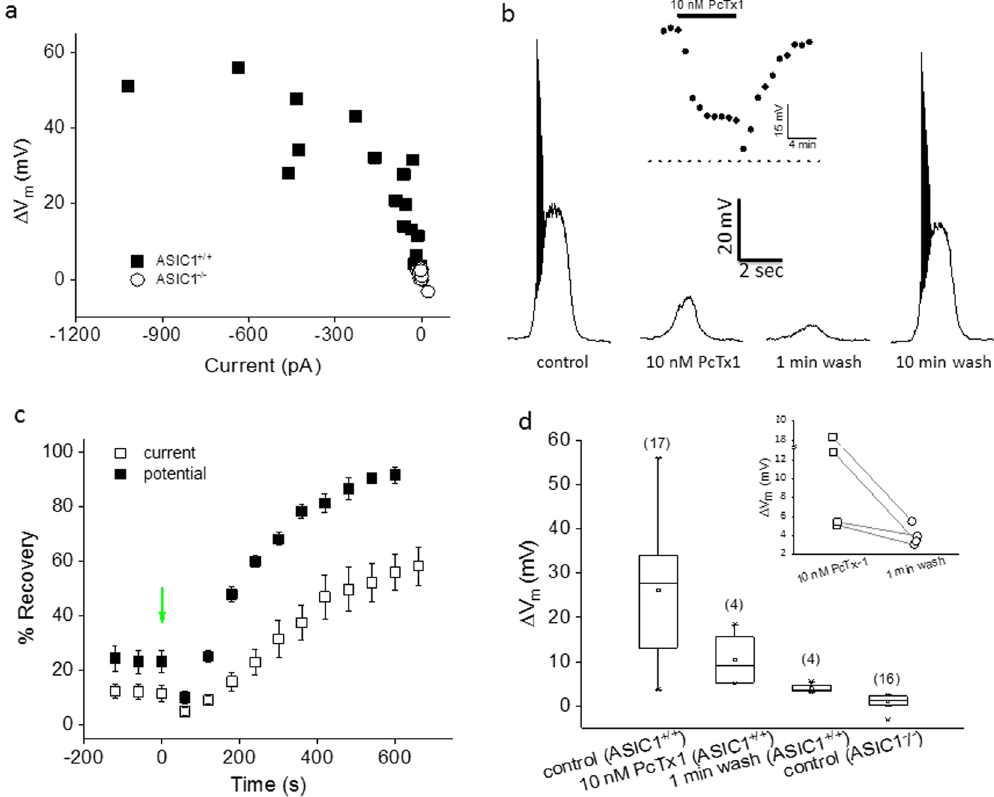
Figure 5. Potentiation of ASIC1a/2a by low concentration PcTx1 in mouse cortical neurons. ( a ) Correlation between pH6.8-induced current and membrane depolarization in wild-type (solid squares; n = 17) and ASIC1 − / − (open circles; n = 16) neurons. Each symbol represents one neuron. ( b ) Traces of pH6.8-induced membrane depolarization from a single neuron in the absence and presence of 10 nM PcTx1. Inset: Time course of the effect of 10 nM PcTx1 and wash. The dotted line at the bottom represents the baseline. ( c ) Time courses of pH6.8-induced responses upon removal of 10 nM PcTx1. Wash began at t = 0 sec as indicated by the green arrow. Open squares: current (n = 4); solid squares: membrane potential (n = 4). Responses were normalized to the control values for each cell just before application of 10 nM PcTx1. Note the initial lower responses (at t = 60 sec) than those in the presence of 10 nM PcTx1 (at t ≤ 0 sec). ( d ) Summary of pH6.8-induced membrane depolarization in wild-type and ASIC1 − / − neurons. Values for wild-type neurons during and upon initial wash of 10 nM PcTx1 were both significantly higher than that from ASIC1 − / − neurons (p < 0.05 and p < 0.0001, respectively). Inset: pair-wise comparison of pH6.8-induced membrane depolarization in the presence of 10 nM PcTx1 and 1 min after wash-off. The former was larger than the latter for all the four wild-type neurons tested, despite not reaching statistical significance (p = 0.11). A typical protocol used for experiments in Fig. 5 was as follows. For current recording, the holding potential was − 80 mV; for membrane potential recording, a small hyperpolarizing current (0–100 pA) was injected to maintain the resting membrane potential near − 70 mV. The conditioning pH was 7.4 and the test pH of 6.8 was applied for 2 sec before returning to pH7.4. This pH application protocol was repeated once every 60 sec. Where applicable, PcTx1 was present in both conditioning and test pH buffers for 4–8 min till reaching steady state before